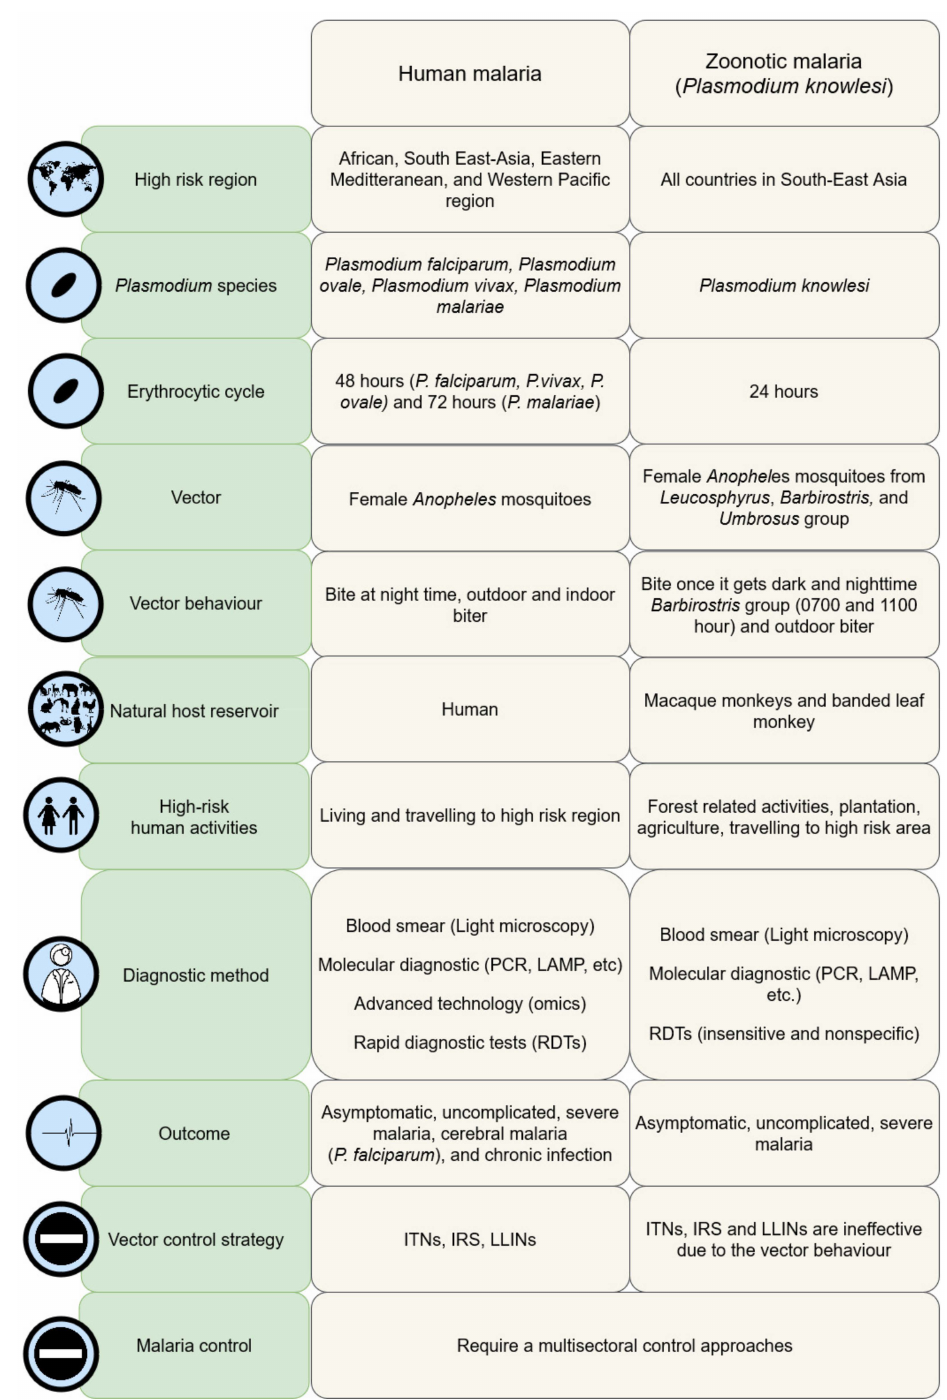
Figure 2. The comparison of human malaria and P. knowlesi